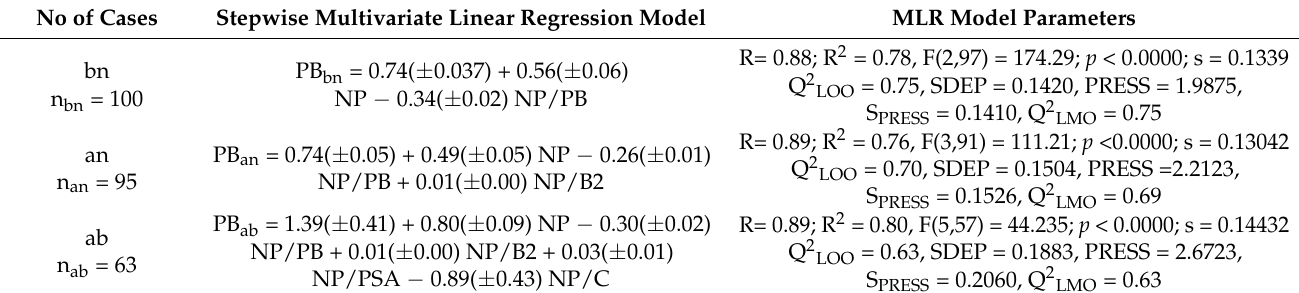
Table 3. MLR models for combined groups of APIs: (bn), (an) and (ab) using NP TLC retention data.